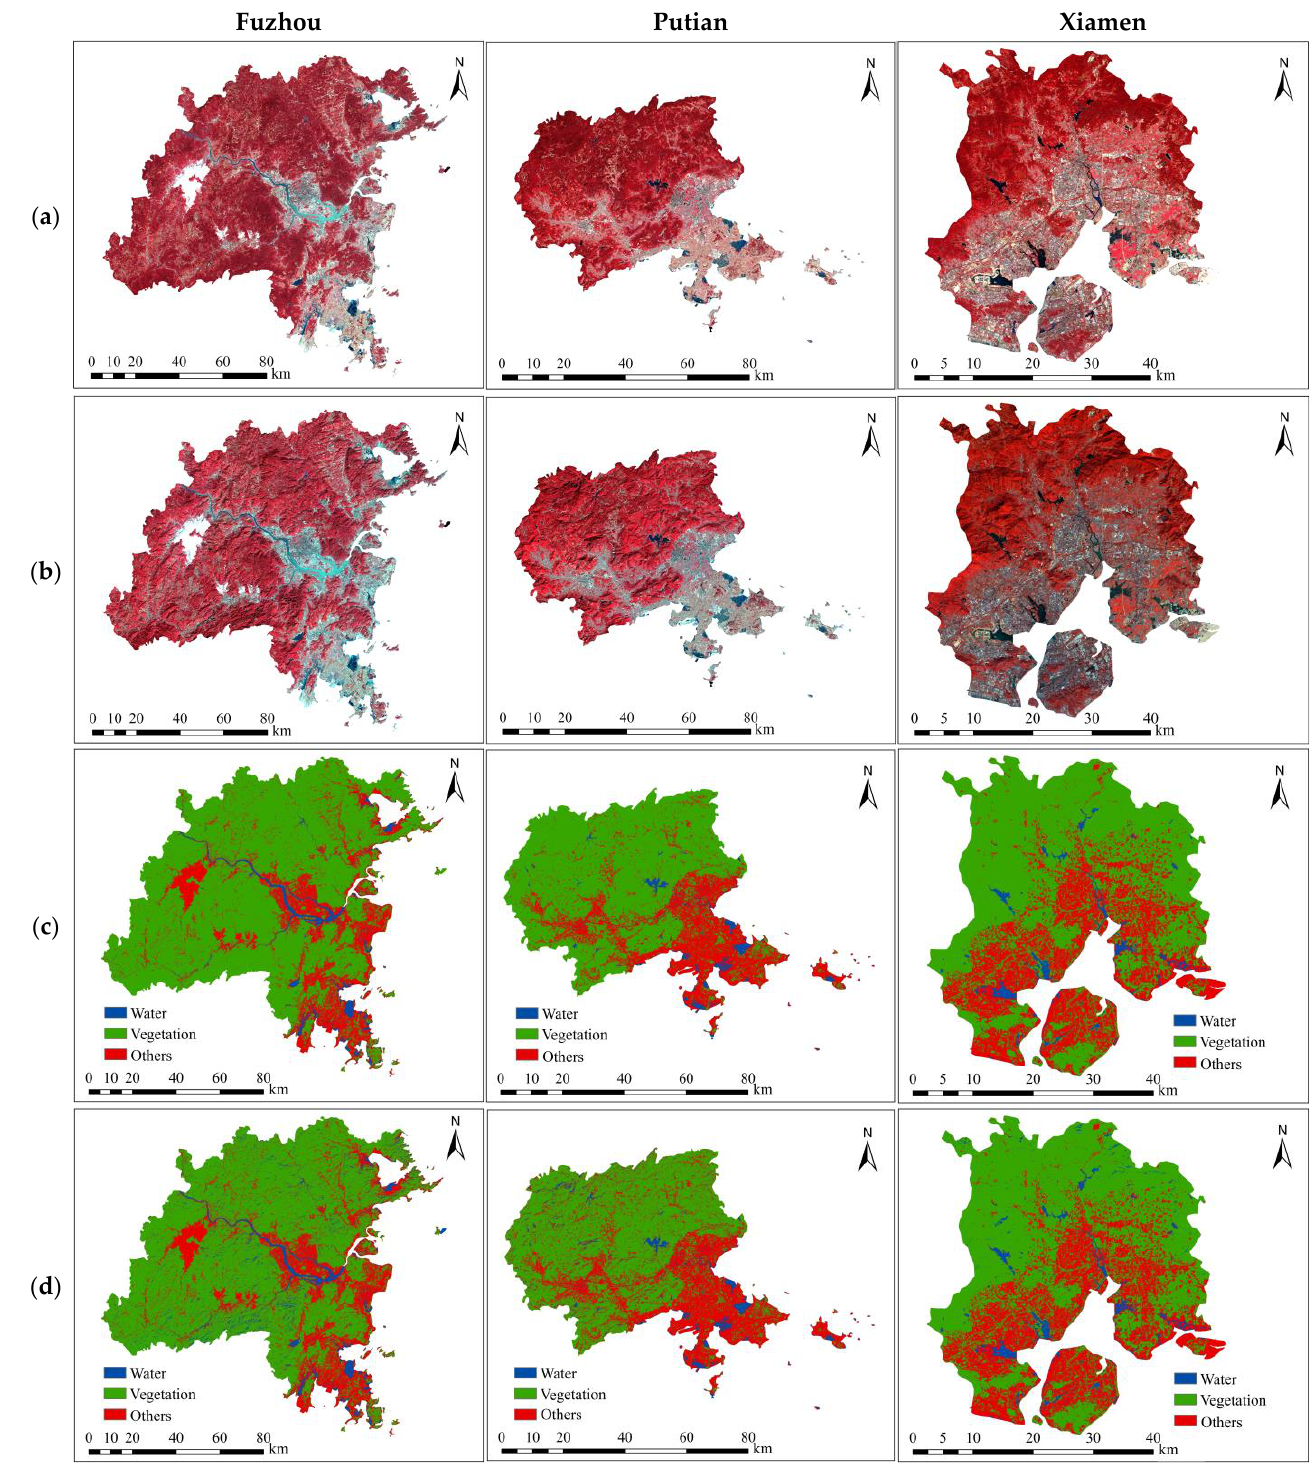
Figure 10. Image of regional cities (NRG composite) and vegetation extraction. ( a ) ITC corrected reflectance, ( b ) Surface reflectance, ( c ) Vegetation extraction using ITC corrected reflectance, ( d ) Vegetation extraction using surface reflectance.